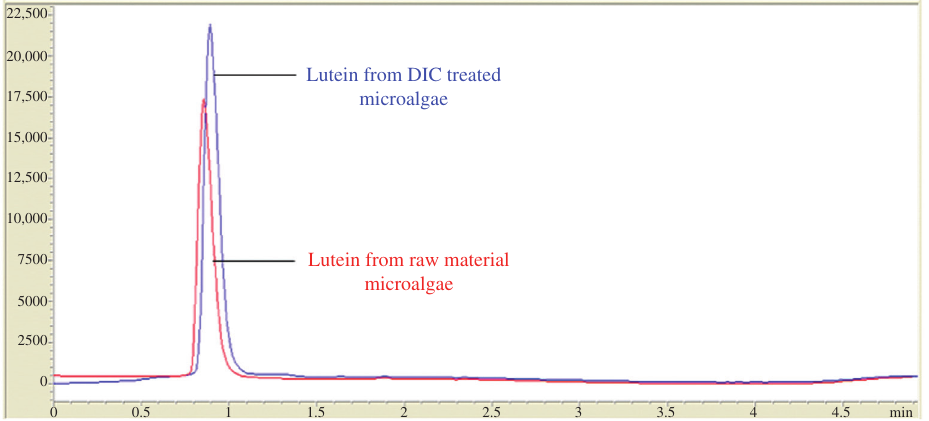
Figure 7 High performance liquid chromatography (HPLC) profile of lutein from microalgae: from instant controlled pressure drop (DIC)- treated sample (1) and raw material